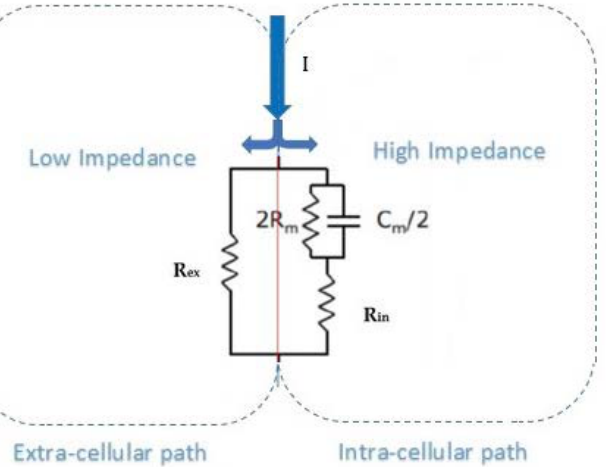
Figure 6. Tissue model based on intra- and extracellular parts as structural components. Performance when frequency approach to DC